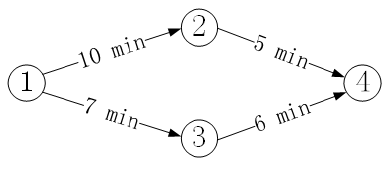
Figure 1. Network diagram.